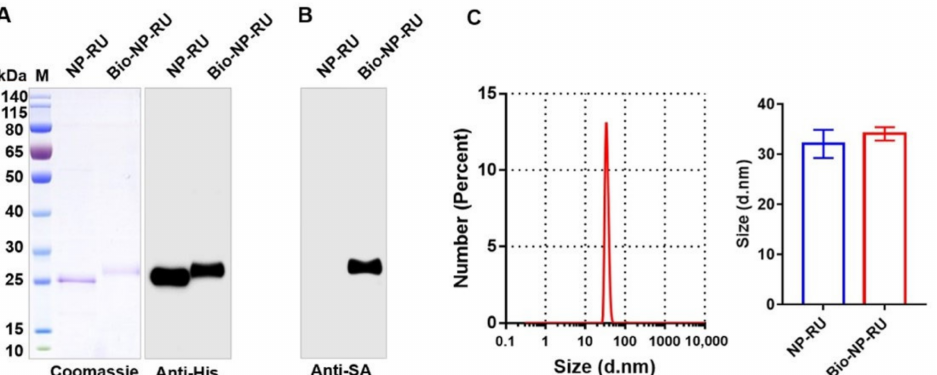
Figure 5. Analysis of biotinylated NP-RUs. NP-RU was biotinylated using EZ-Link NHS-LC-LC- Biotin Reagents (Thermo Fisher, American) and the product was analyzed by Coomassie blue staining and anti-6 × His Western blotting ( A ). ( B ) Biotin on NP-RU was detected through Western blotting using HRP-conjugated streptavidin (Anti-SA). ( C ) DLS analysis of Bio-NP-RU. Each experiment was carried out at least